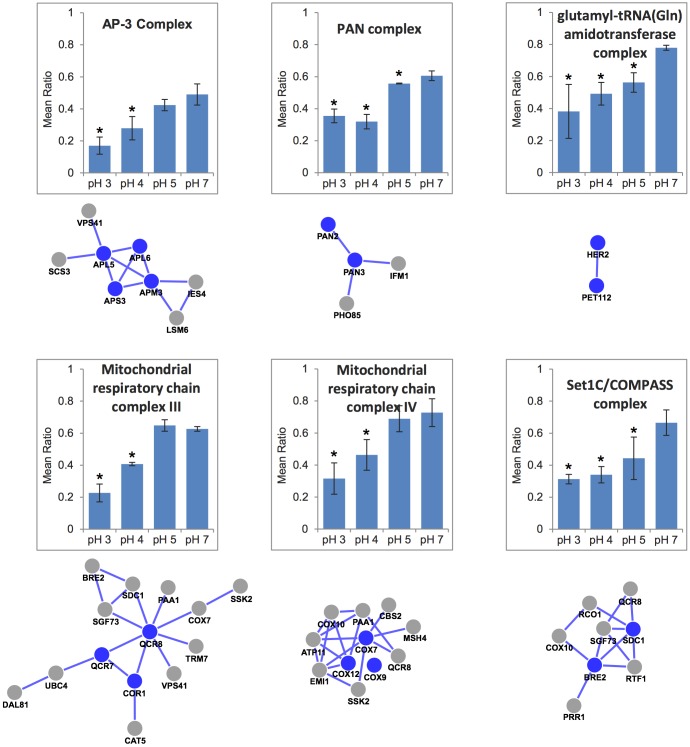
Identification of acid stress resistance complexes. Complexes were identified using the GeneMania plugin for Cytoscape using the pH 4 acid stress screen gene set. Blue nodes indicate proteins identified in the screen that are subunits of the complexes, whereas grey nodes indicate proteins identified in the screen that interact with the complexes. Edges indicate protein–protein interactions. Graphs show the average for the complexes of the mean ratios of growth for double mutants relative to single mutant controls (as in Fig. 4) for the screens performed at the indicated pH (n=3 for each subunit). Error bars indicate s.e.m. *P<0.05 vs pH 7 by Student's t-test.